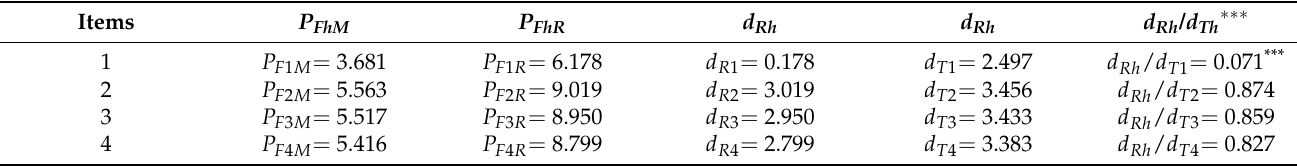
Table 4. Fuzzy evaluation table for physical